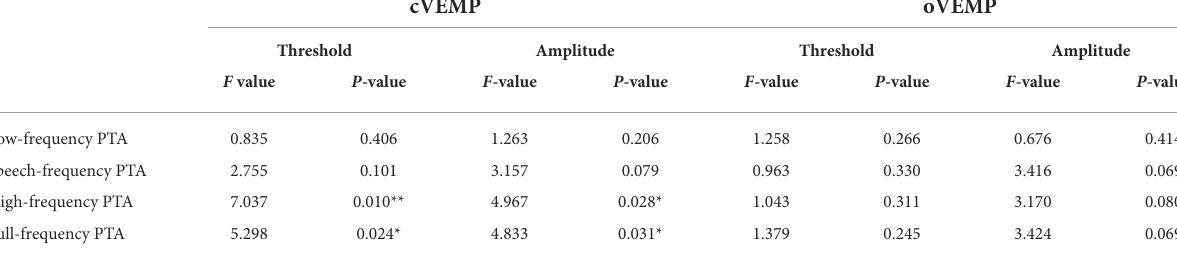
TABLE 3 Correlation between PTAs at different frequency bands and VEMP results by linear regression.